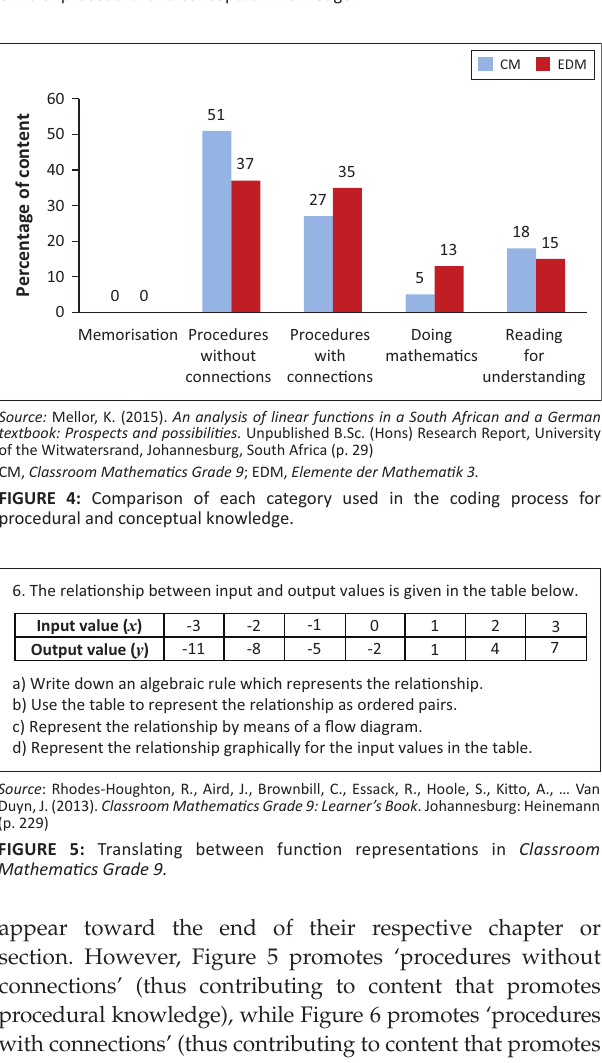
FIGURE 3: Analysis of coded content blocks, sequenced as in the respective chapters, in terms of procedural and conceptual knowledge.